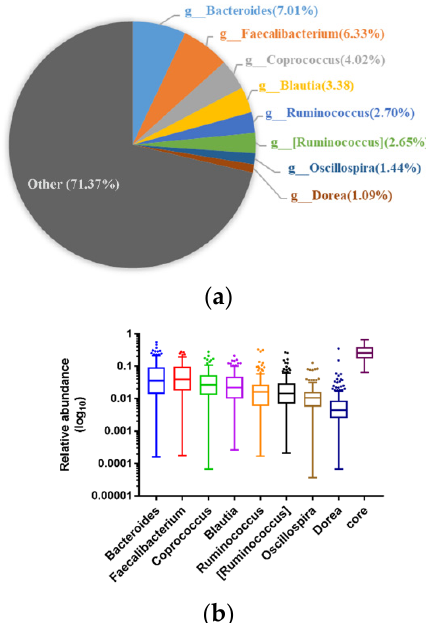
Figure 5. The core genera shared by all the samples. ( a ) represents the average proportion of each core genus within the whole sequences. ( b ) represents the distribution of the relative abundance of each genus and their collection. Boxes show the interquartile range (IQR) between the first and third quartiles, and the lines inside boxes represent the median. Whiskers denote the lowest and highest values within 1.5 × IQR from the first and third quartiles, respectively. The colored points present the values with distance from the median exceeding 1.5 times of IQR.